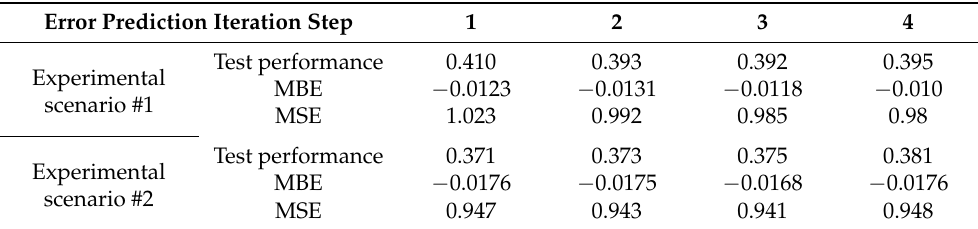
Table 12. Unified power prediction results for the error prediction in four iteration